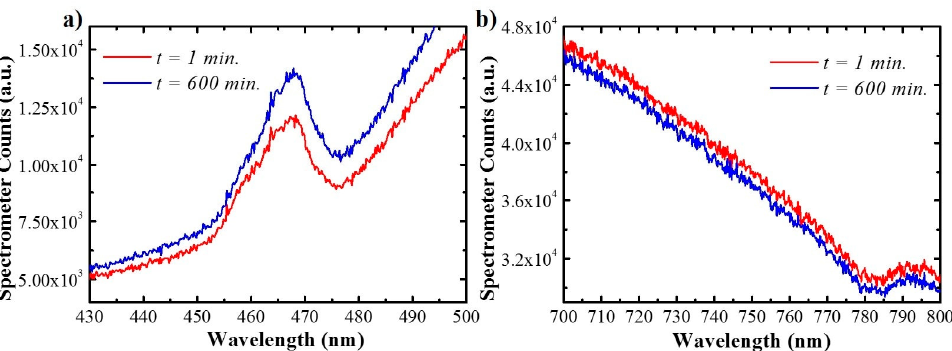
Figure 7. Spectra registered after wetting using reflectance spectroscopy at time instants t = 1 and 600 min for wavelength range that include the PSB ( a ), and reference wavelength range ( b ) in Hy-NAA-GIF.